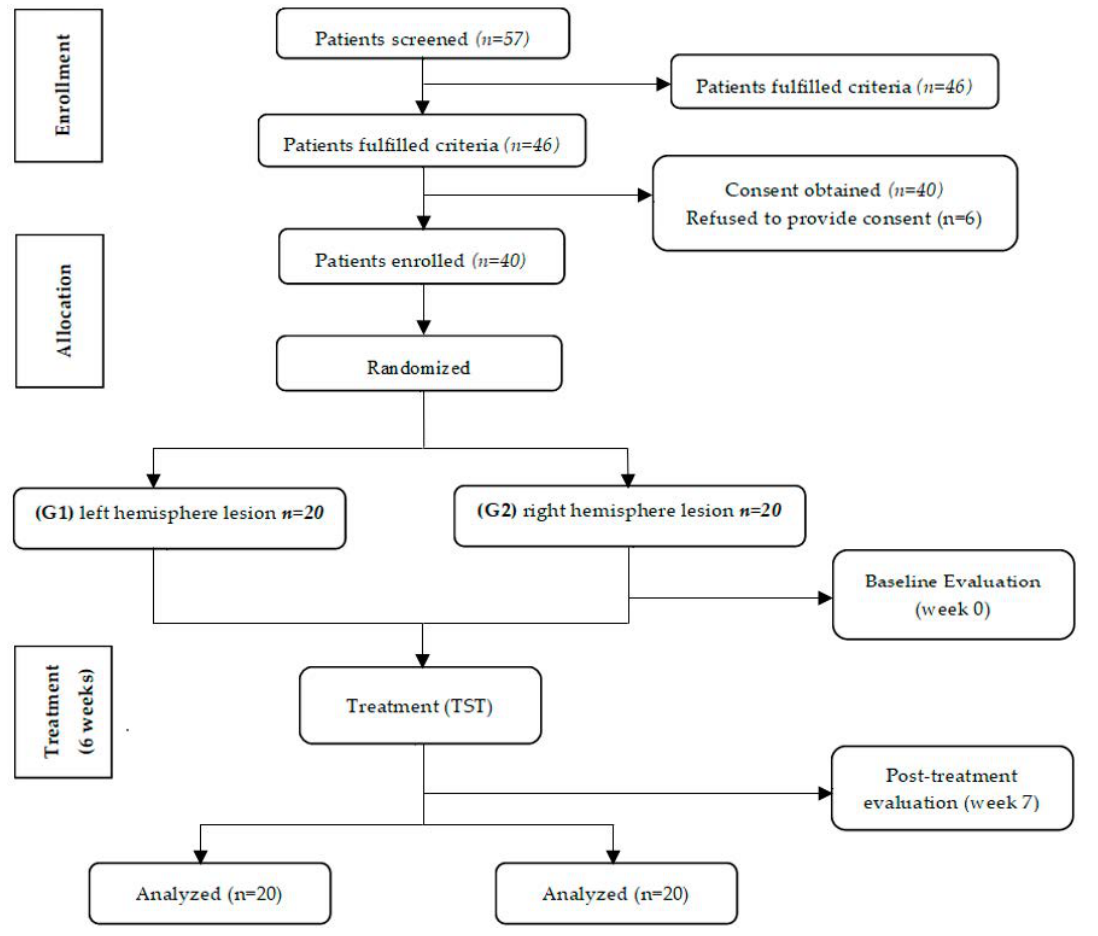
Figure 1. Flow diagram of the study.